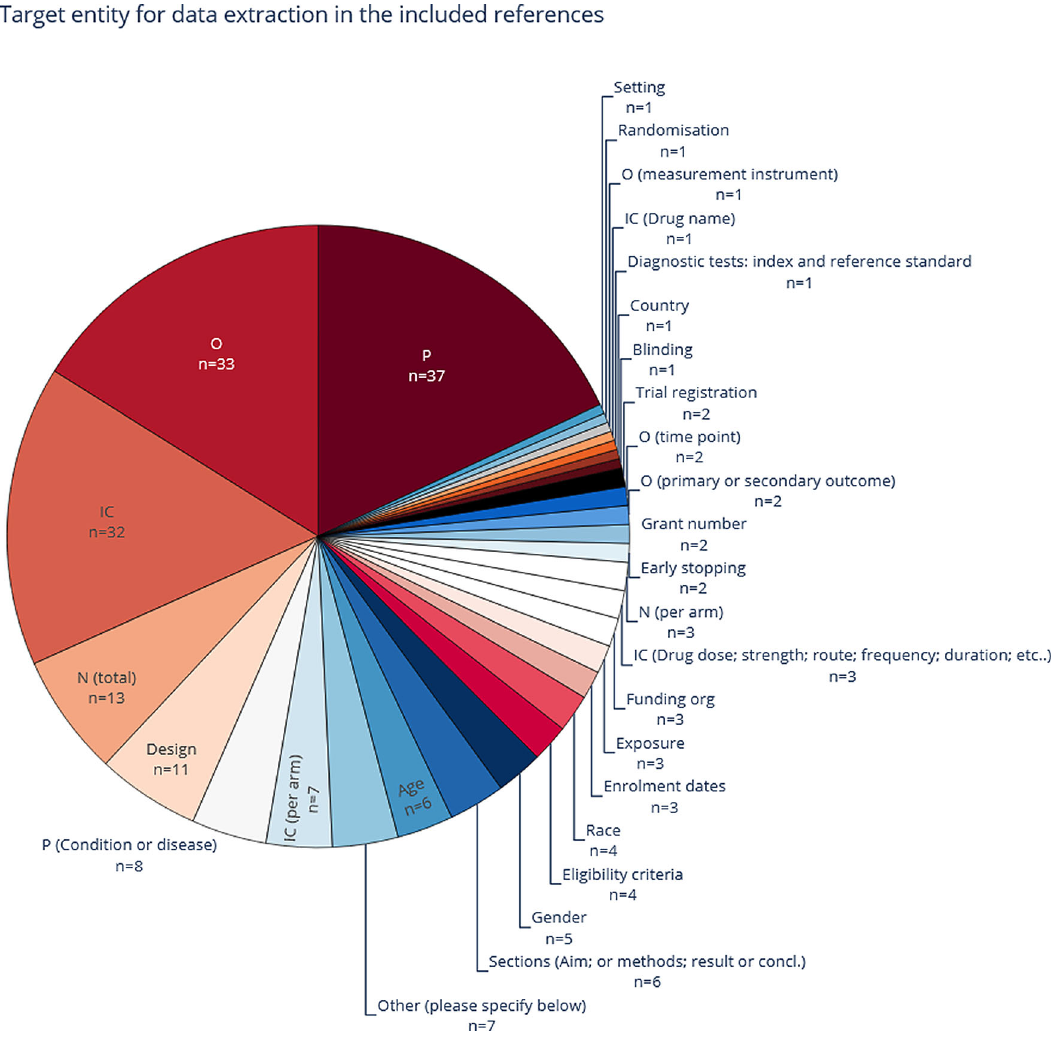
Figure 7. The most common entities, as extracted in the included publications. More than one entity type per publication is common, which means that the total number of included publications (n = 53) is lower than the sum of counts within this figure. P, population; I, intervention; C, comparison; O,